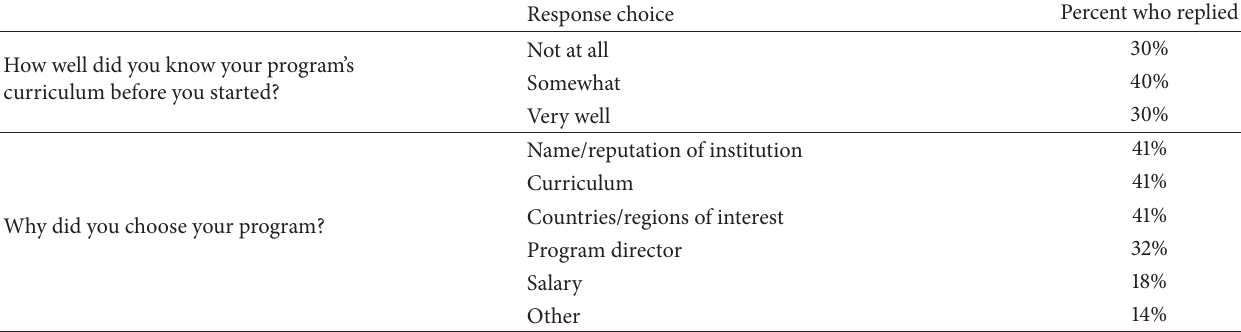
Table 1: Fellows’ prior knowledge of curriculum and reasons for choosing program.